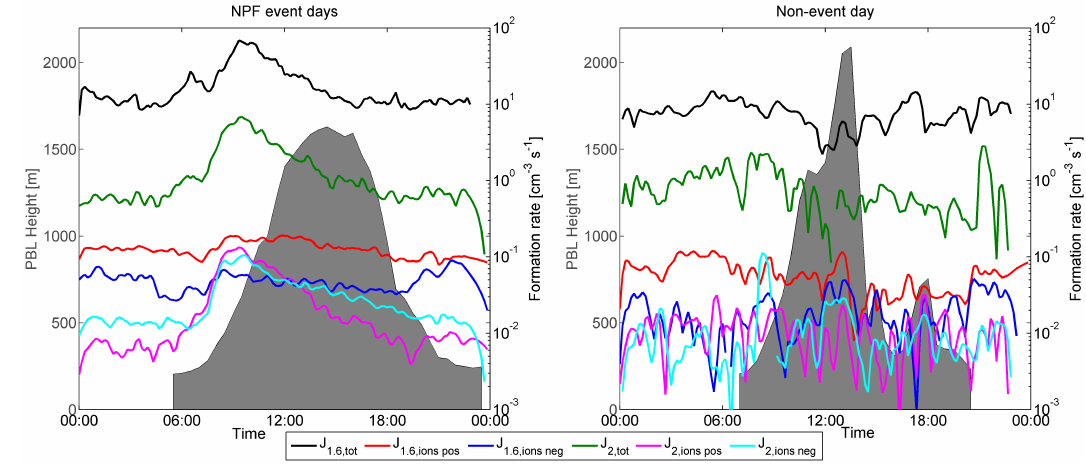
Figure 8. The median diurnal variation of the cluster formation rates at 1.6 and 2nm on NPF event days and on the only non-event day (6 July 2012). The PBL height is shown in grey. In the subscripts, numbers refer to the size of the cluster in nanometers, and “tot” refers to total clusters, “pos” to positive ions and “neg” to negative ions. Time is UTC +